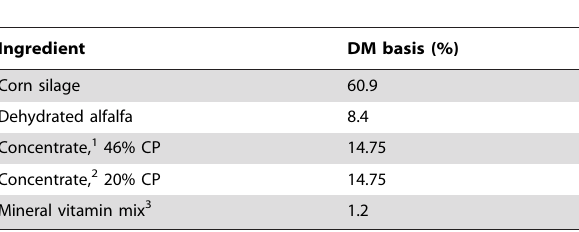
Table 1. Composition of the diet on a DM basis (%).